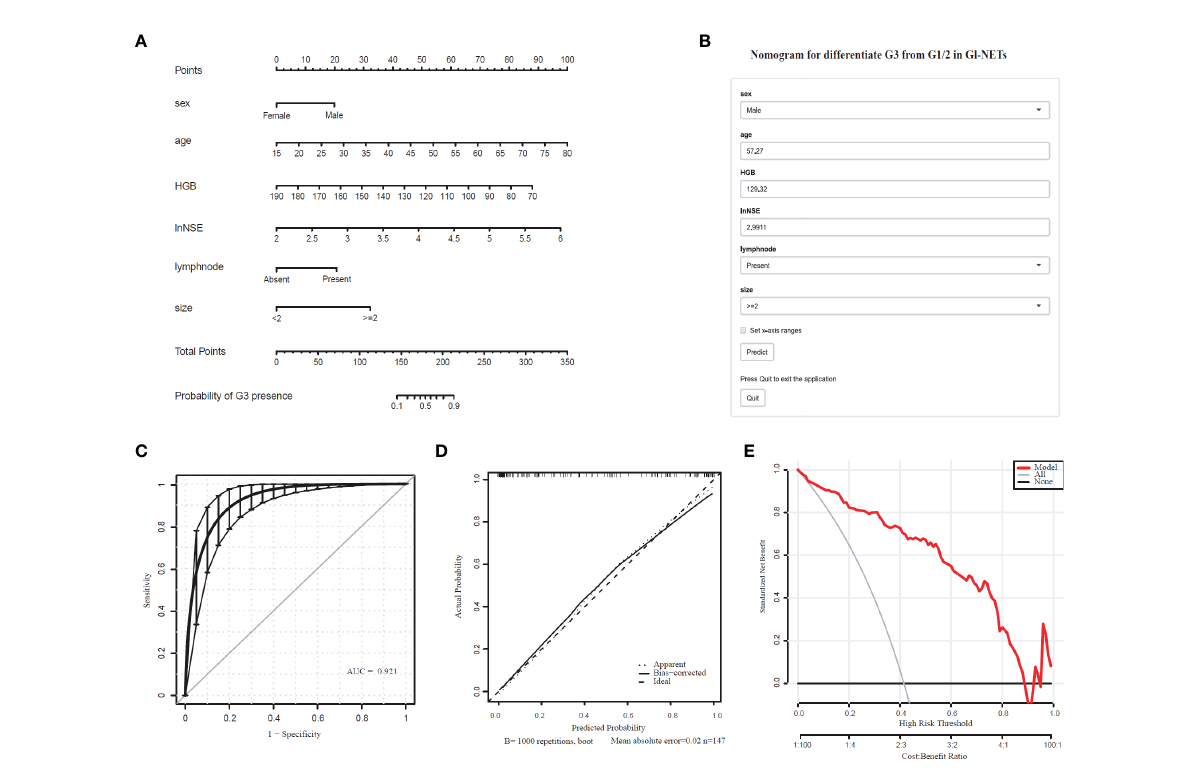
FIGURE 1 Nomogram for Preoperative Estimation of G3 Risk and Its Predictive Performance. (A) , Nomogram to estimate the risk of G3 presence in GI- NETs. (B) , corresponding online calculators to predict the risk of G3. Online tools are available at http://ginet.shiny.io/dynnomapp/. (C) , Receiver operating characteristic ROC. (D) , the calibration curve and (E) , the decision